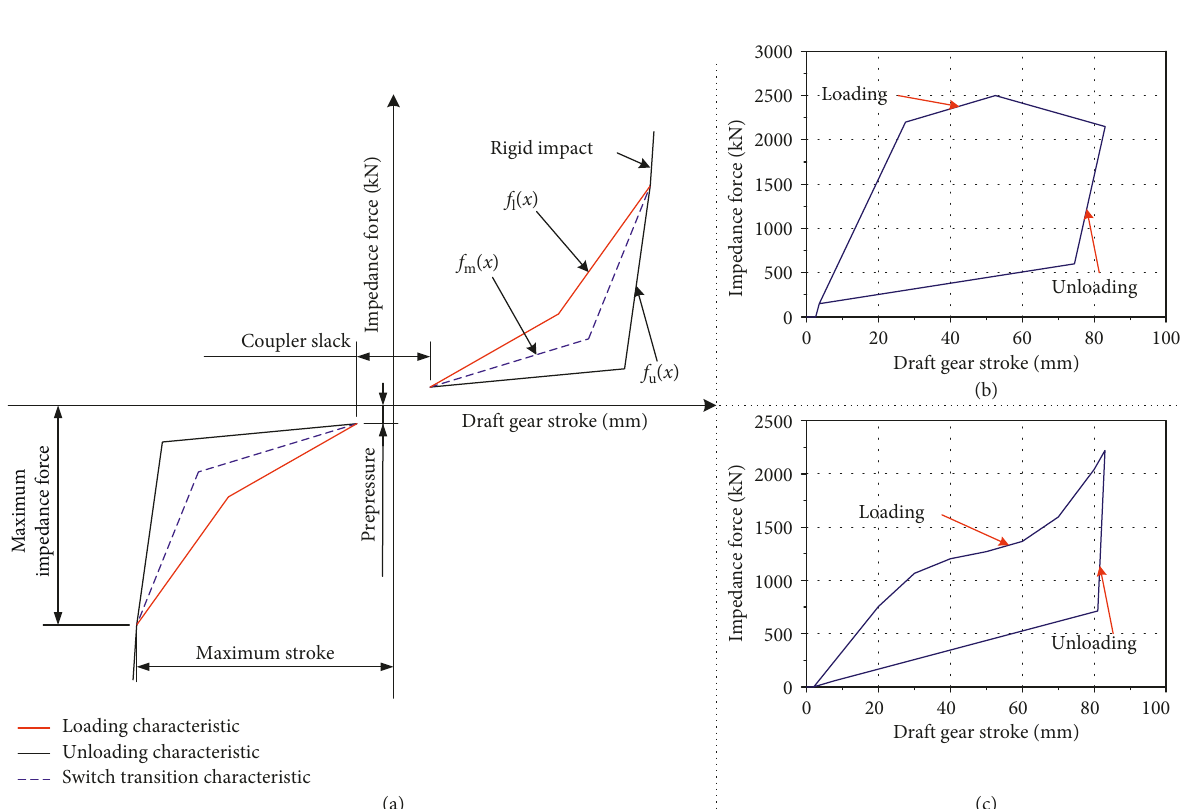
Figure 6: Draft gear: (a) the velocity-dependent model; (b) the nonlinear hysteretic characteristics of the QKX100 graft gear; (c) the nonlinear hysteretic characteristics of the MT-2 graft